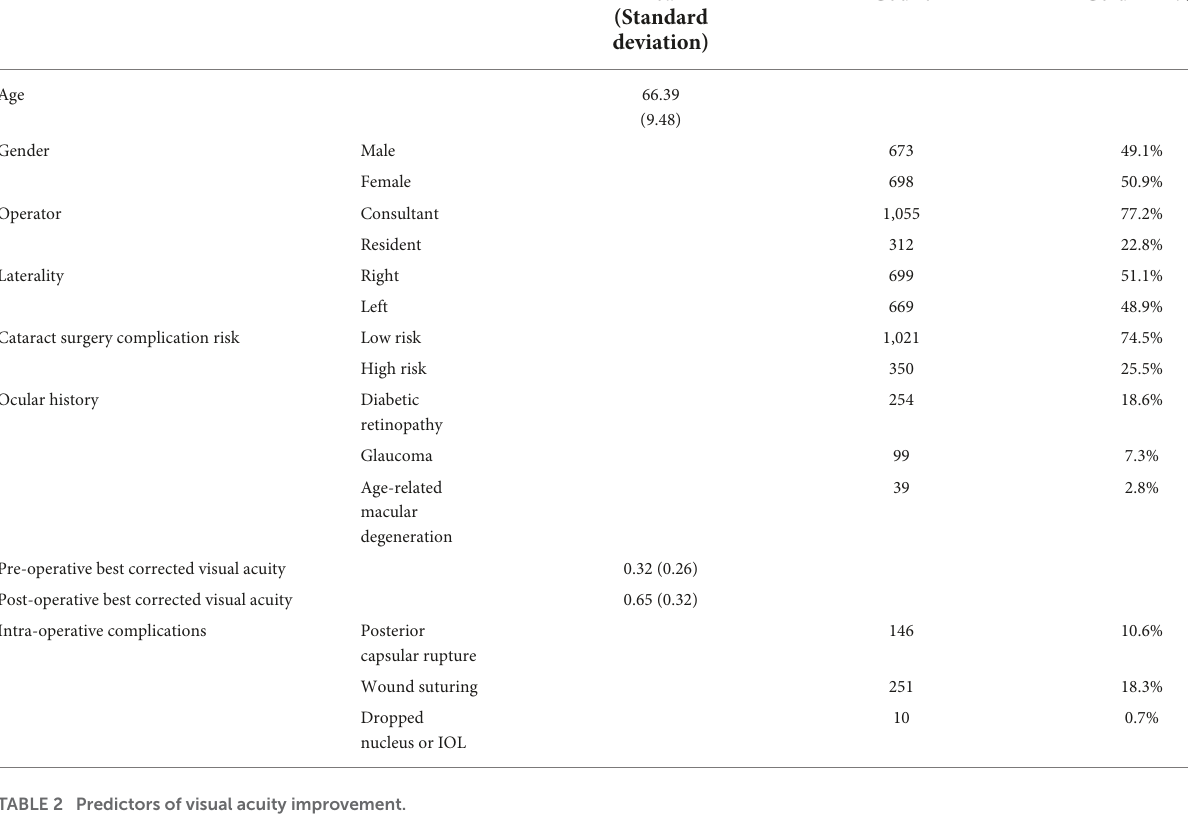
TABLE 1 The characteristics of included sample.